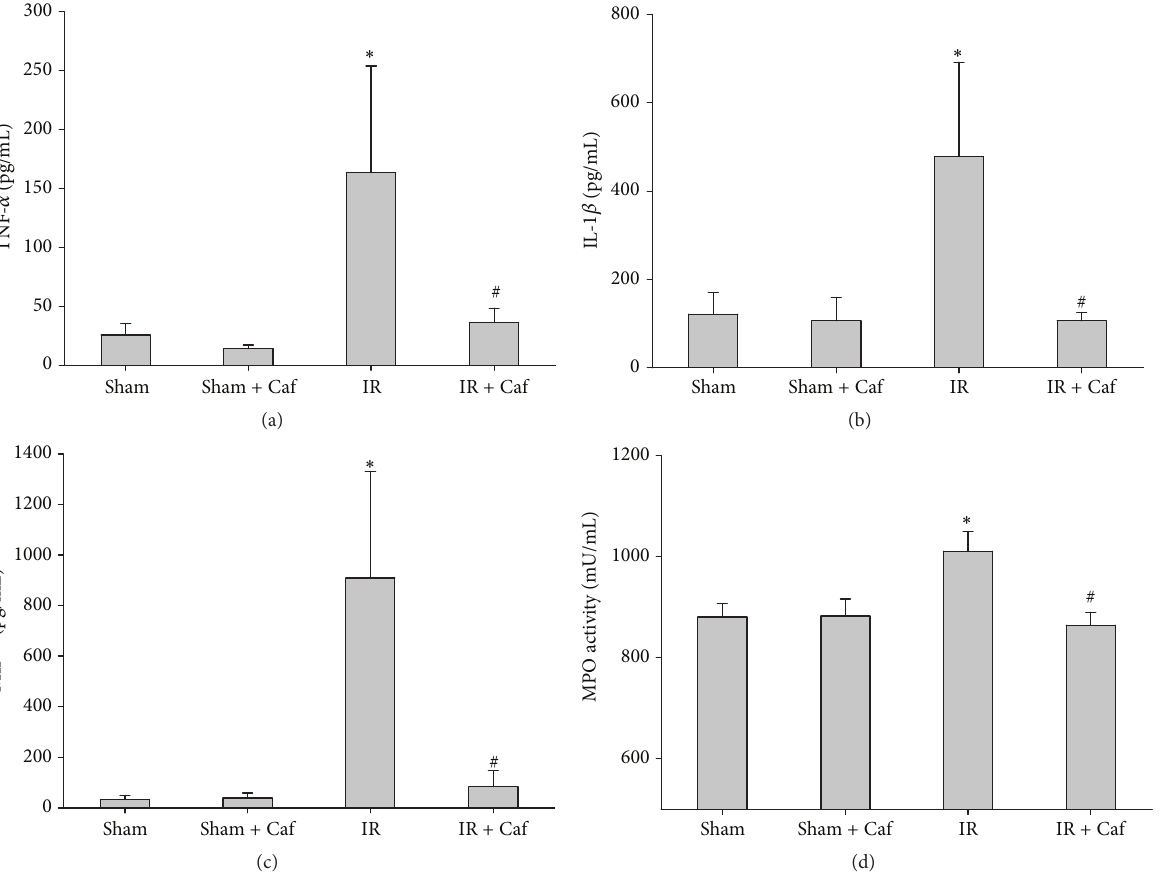
Figure 3: The pulmonary concentrations of (a) tumor necrosis factor- 𝛼 (TNF- 𝛼 ), (b) interleukin-1 𝛽 (IL-1 𝛽 ), (c) macrophage inflammatory protein-2 (MIP-2), and (d) myeloperoxidase (MPO) activity. Sham: the sham-operation group. Sham + Caf: the sham plus caffeine group. IR: the lower limb ischemia-reperfusion group. IR + Caf: the IR plus caffeine group. Rats of the Sham + Caf and the IR + Caf groups received caffeine (50mg/kg, intraperitoneal injection) immediately after reperfusion. To control for the effects of treatment vehicle, rats of the Sham and the IR group received normal saline (1.0mL, intraperitoneal injection) at the comparable time point. One-way analysis of variance with the Bonferroni-Dunn test was used for multiple comparisons. The significance level was set at 0.05. Data were derived from 6 rats from each group and presented as mean ± standard deviation. ∗ 𝑃 < 0.05 : the IR group versus the Sham group. # 𝑃 < 0.05 : the IR + Caf group versus the IR